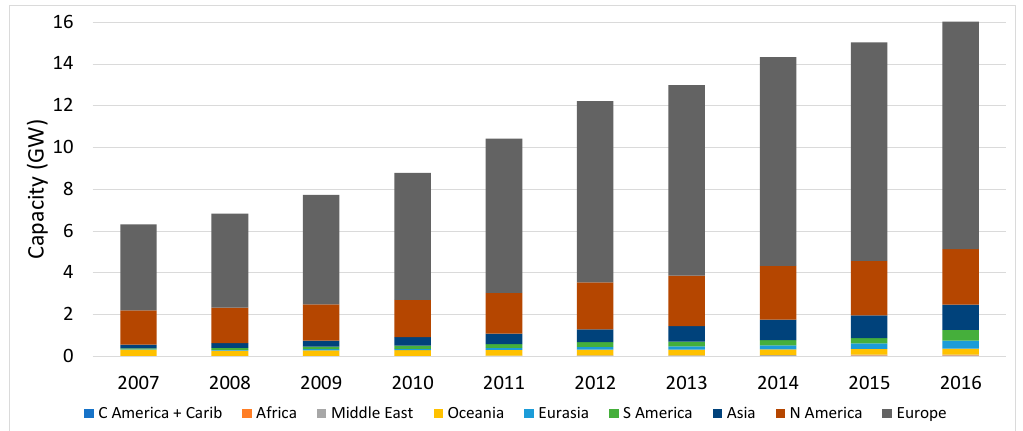
Figure 1. Global installed biogas plant capacity between 2007 and 2016 [85]. Figure 1 . Global installed biogas plant capacity between 2007 and 2016 [85]. Figure 1 . Global installed biogas plant capacity between 2007 and 2016 [85].